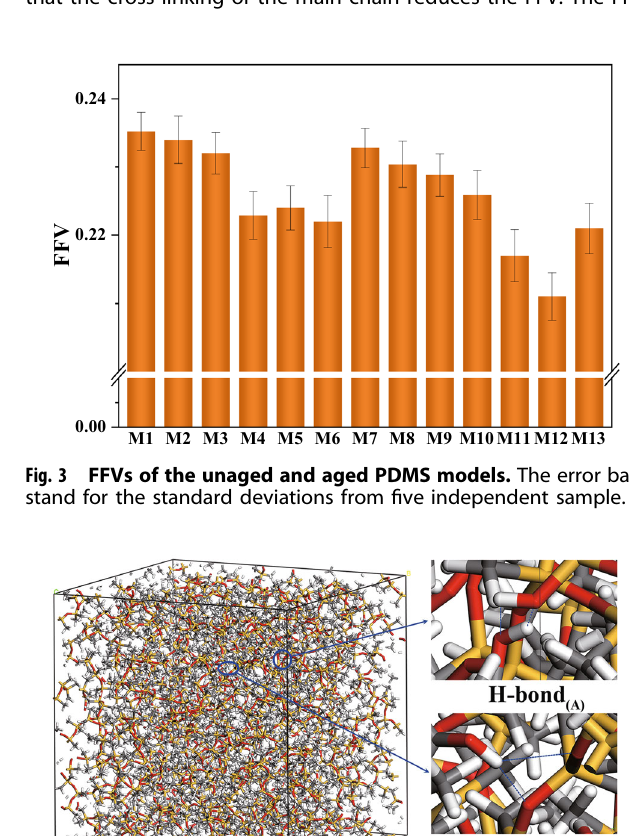
Fig. 2 The average densities of the unaged and aged PDMS models. The error bars stand for the standard deviations from fi ve independent sample.